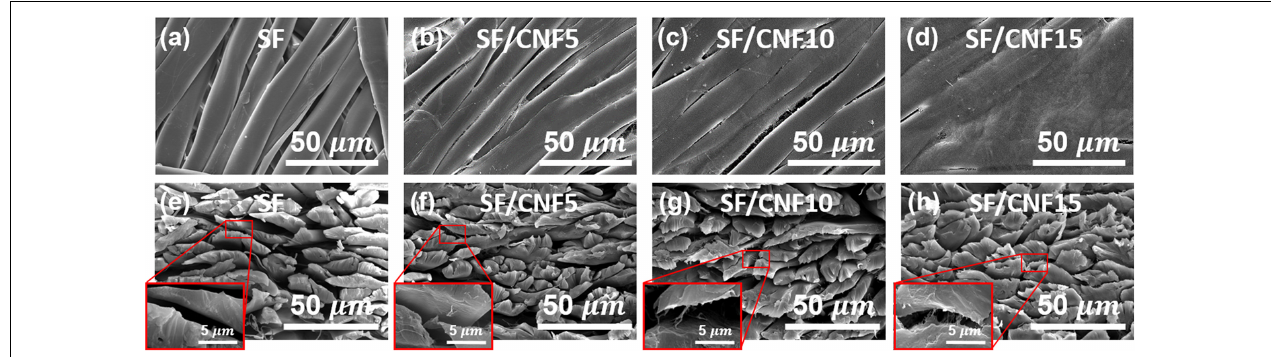
FIGURE 4 | FE-SEM images of the SF/CNF composites with various CNF concentrations. Surface (a–d) and cross section (e–h) images; (a,e) : SF nonwoven, (b,f) : SF/CNF5, (c,g) : SF/CNF10, (d,h) : SF/CNF15. The insets represent high-magnitude images.